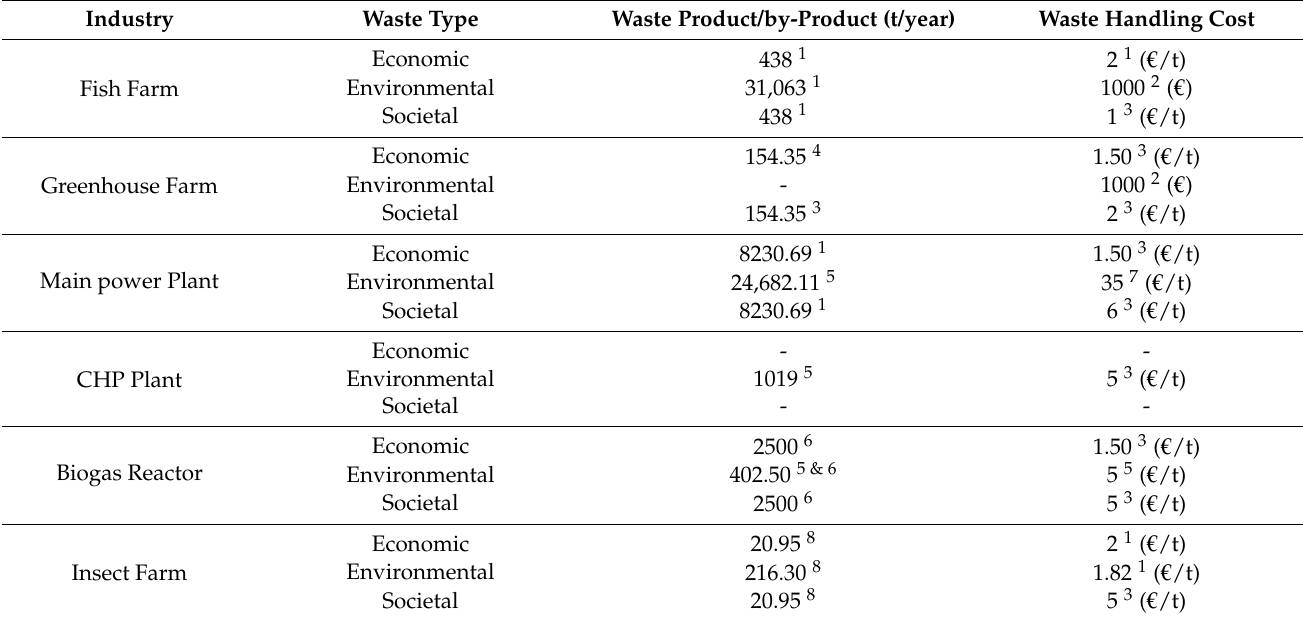
Table 4. Life cycle cost of waste management.